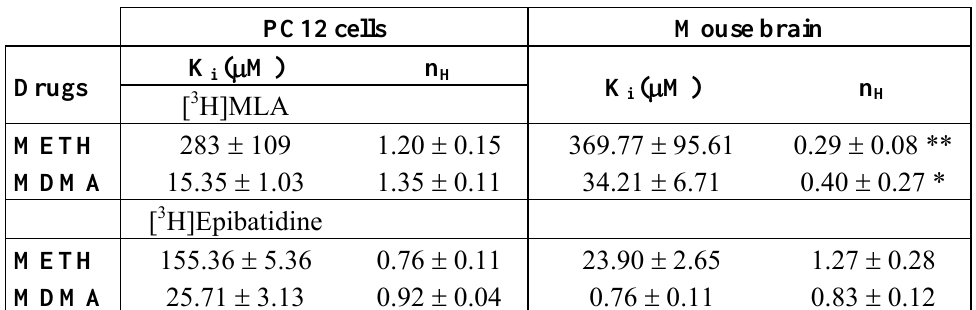
Table 1. K values of METH and MDMA against [ 3 H]MLA and [ 3 H]epibatidine binding in i PC12 cells and mouse brain. n is the Hill coefficient. * P < 0.05 and ** P < 0.01 vs. 1 H (one sample t test). Data reproduced from